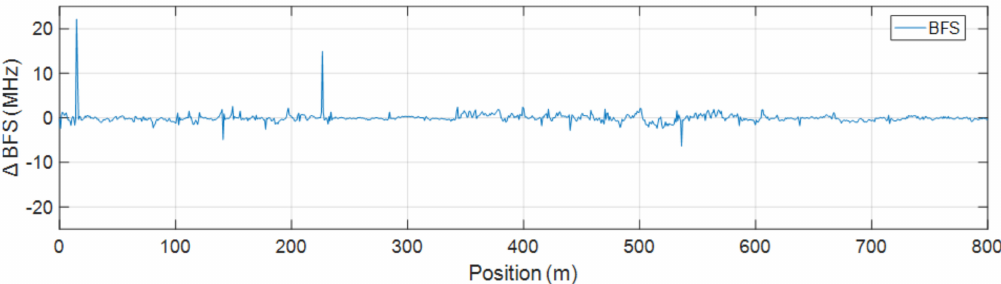
Figure 10. Example of mapping of a reference point. Both D-FOS temperature and strain cables